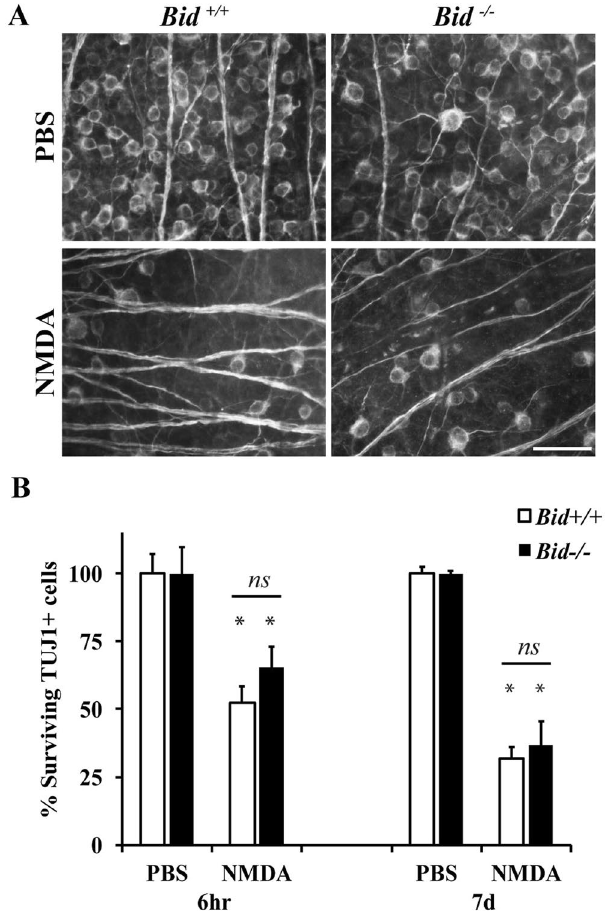
Figure 3. Bid deficiency does not prevent RGC death after excitotoxic insult. BID is a major regulator of extrinsically-induced cell death. To determine if BID is required for NMDA induced RGC death, 2 μ l PBS or 20 mM NMDA was intravitreally injected into wildtype Bid ( Bid + / + ) and Bid deficient ( Bid − / − ) mice. The number of surviving RGCs (TUJ1 + cells) were counted 6 hours (hr) and 7 days (d) after intravitreal NMDA injection (n = 5 for 6 hr PBS Bid + / + , n = 5 for 6 hr NMDA Bid + / + , n = 5 for 6 hr PBS Bid − / − , n = 5 for 6 hr NMDA Bid − / − , n = 6 for 7d PBS Bid + / + , n = 6 for 7d NMDA Bid + / + , n = 7 for 7d PBS Bid − / − , n = 7 for 7d NMDA Bid − / − ). ( A ) Representative images from flat mounted retinas stained with anti-TUJ1 show clear RGC loss in both wildtype and Bid deficient mice after NMDA insult at both time points examined. ( B ) Quantification of TUJ1 + RGCs showed a significant loss of TUJ1 + cells in both wildtype and Bid deficient mice at both 6 hours and 7 days after injury ( * p < 0.001 for PBS to NMDA comparisons). Note, there was no difference in RGC number between Bid wildtype and deficient mice at either time ( p ≥ 0.719 for each time point). Scale bar: 50 μ